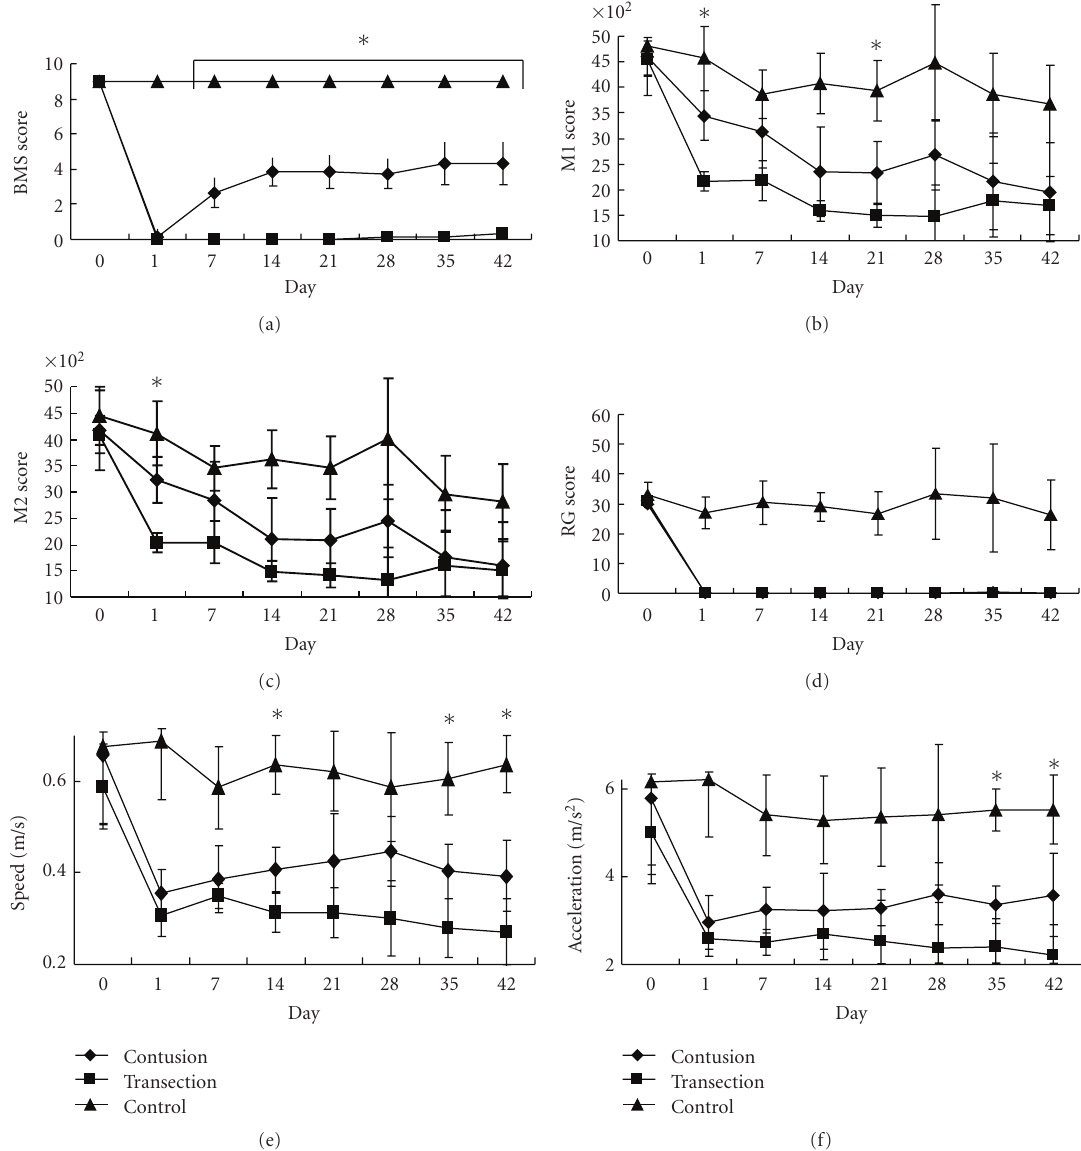
Figure 3: Time course of each parameter. (a) BMS score. (b) M1 score. (c) M2 score. (d) Rearing score (RG). (e) Speed. (f) Acceleration. M1 and M2 scores hardly showed a di ff erence between the contusion and transection groups after 1 week, and they gradually decreased despite the animal’s recovery of BMS score. The speed and acceleration showed clear di ff erences among the three groups, especially in the late phase of SCI. ∗ P < .